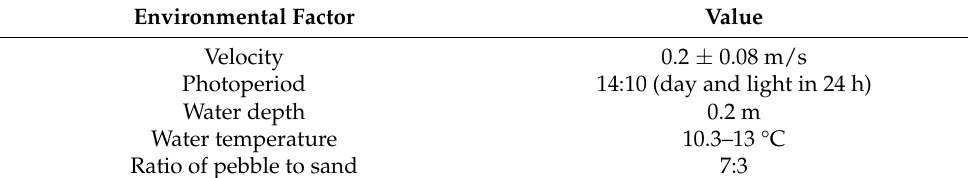
Table 2. Environmental parameters of the natural spawning grounds of G. przewalskii .